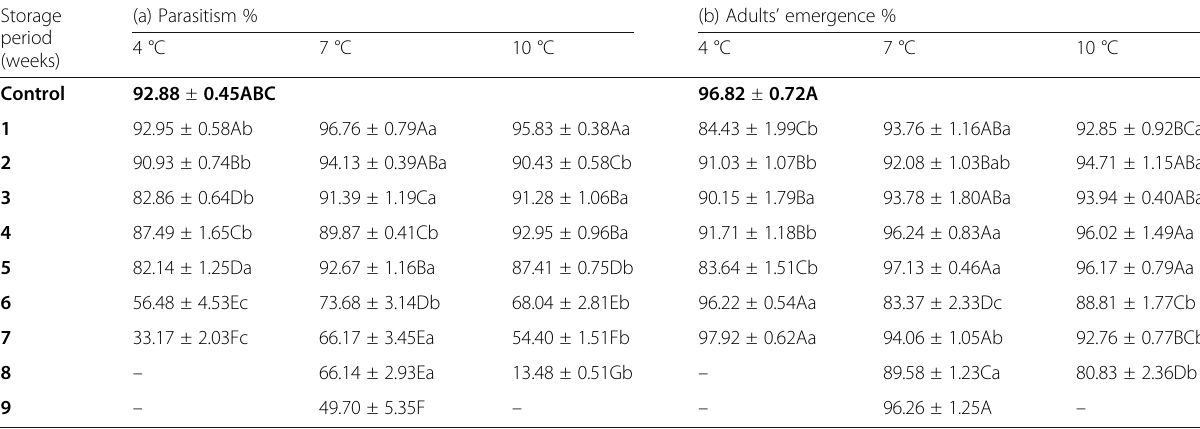
Table 9 Percentages of parasitism and adults' emergence of Trichogrammatoidea bactrae in F 1 progeny during storage of parasitoid pupae at different low temperatures Storage